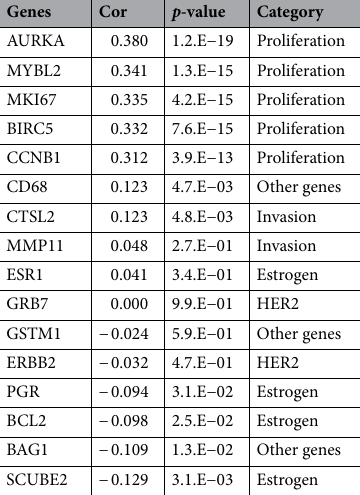
Genes Cor p -value